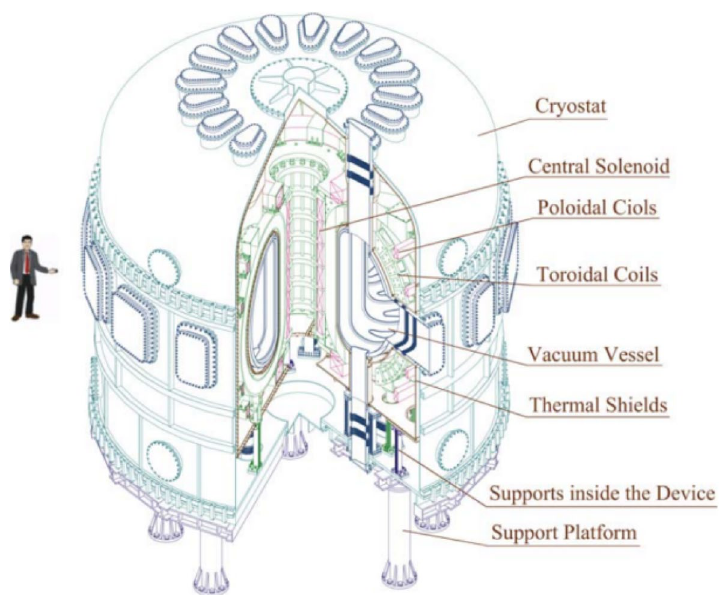
Fig. 2 The cutaway isometric drawing of the EAST main